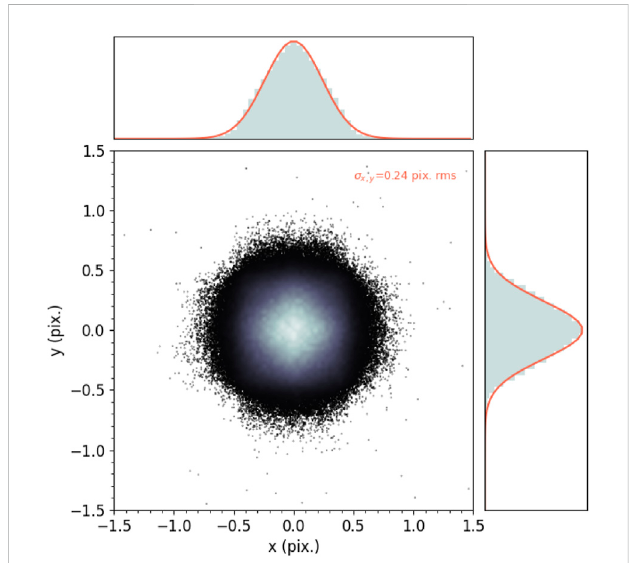
FIGURE 3 Statistical distribution of the distance of the real impinging point from the event centroid. A brighter color means a higher probability density value. On top and on the right-hand side, the x and y marginal distributions of the simulated data and of the two-dimensional Gaussian fi tting.